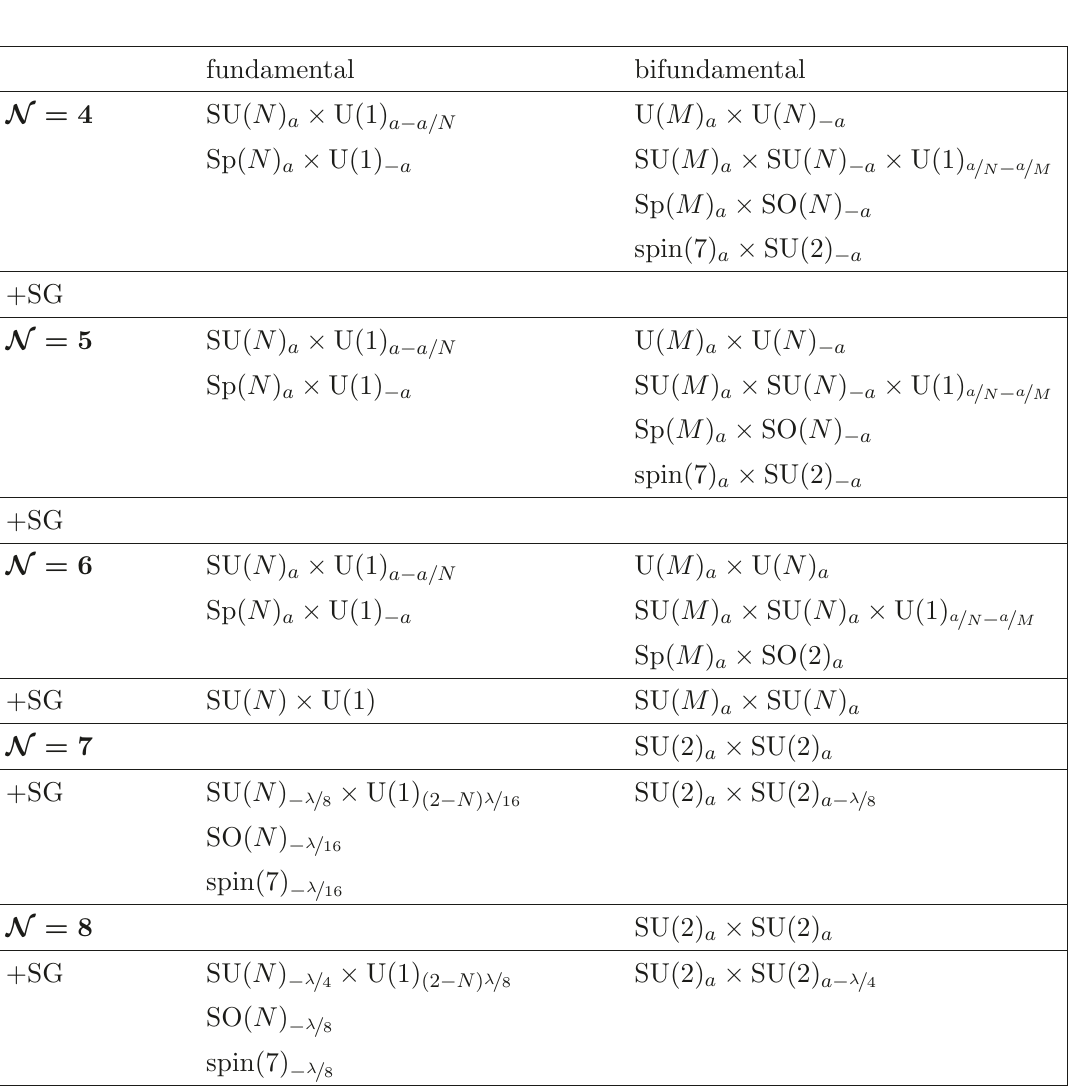
Table 1 . Allowed gauge groups for the (spin( )-chiral) scalar compensator in flat space and N additional groups in the presence of supergravity. Subscripts of the group factors indicate the relative coupling constants (or restricted charges), where for 6 the Chern-Simons currents N ≥ corresponding to the right-acting factors will be coupled with opposite sign in the action. Some of the groups with fundamental representation correspond to limits of bifundamental